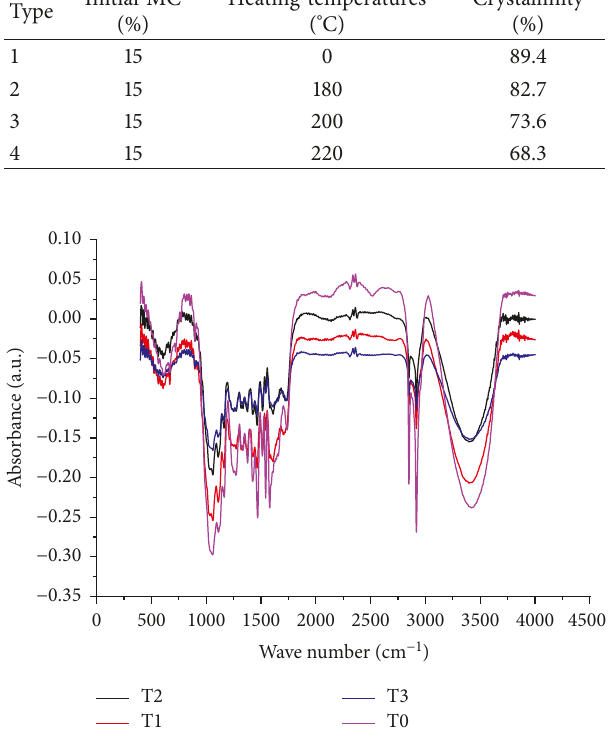
Table 4: Weight loss of untreated and heat-treated specimens after decay resistance tests.